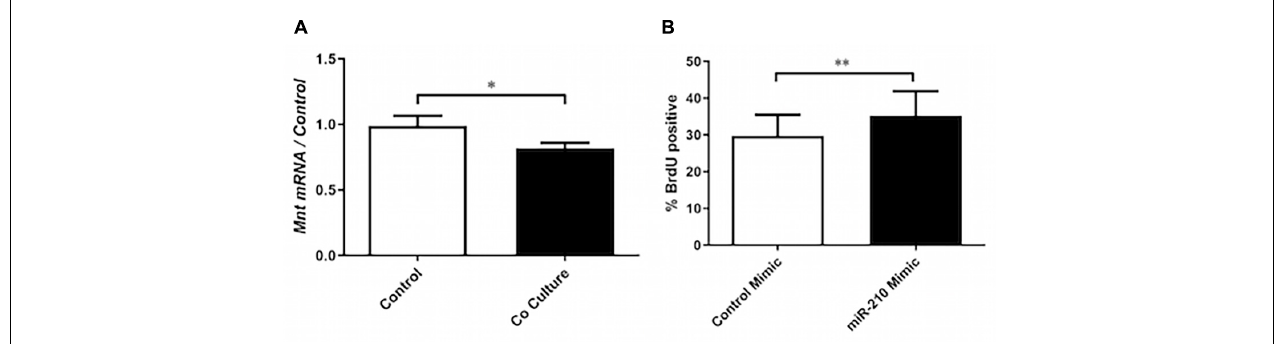
FIGURE 3 | miR-210s role in co-culture induced proliferation. (A) RT-qPCR was performed on mRNA of ASM cells that had been co-cultured or not (control) with BEAS-2B cells for 24 h to assess the expression of Max-binding protein (Mnt) ( n = 9). (B) ASM cells were transfected with a mimic of miR-210-3p or cel-miR-39-3p (control) prior to BrdU assay to assess the role of miR-210-3p in proliferation ( n = 5). Data are representative of means + 1 SE. ANOVA with Tukey’s post hoc pairwise comparisons were employed for comparisons with more than two groups, otherwise Student’s paired t -test was utilized. ∗ P < 0.05; ∗∗ P < 0.01.